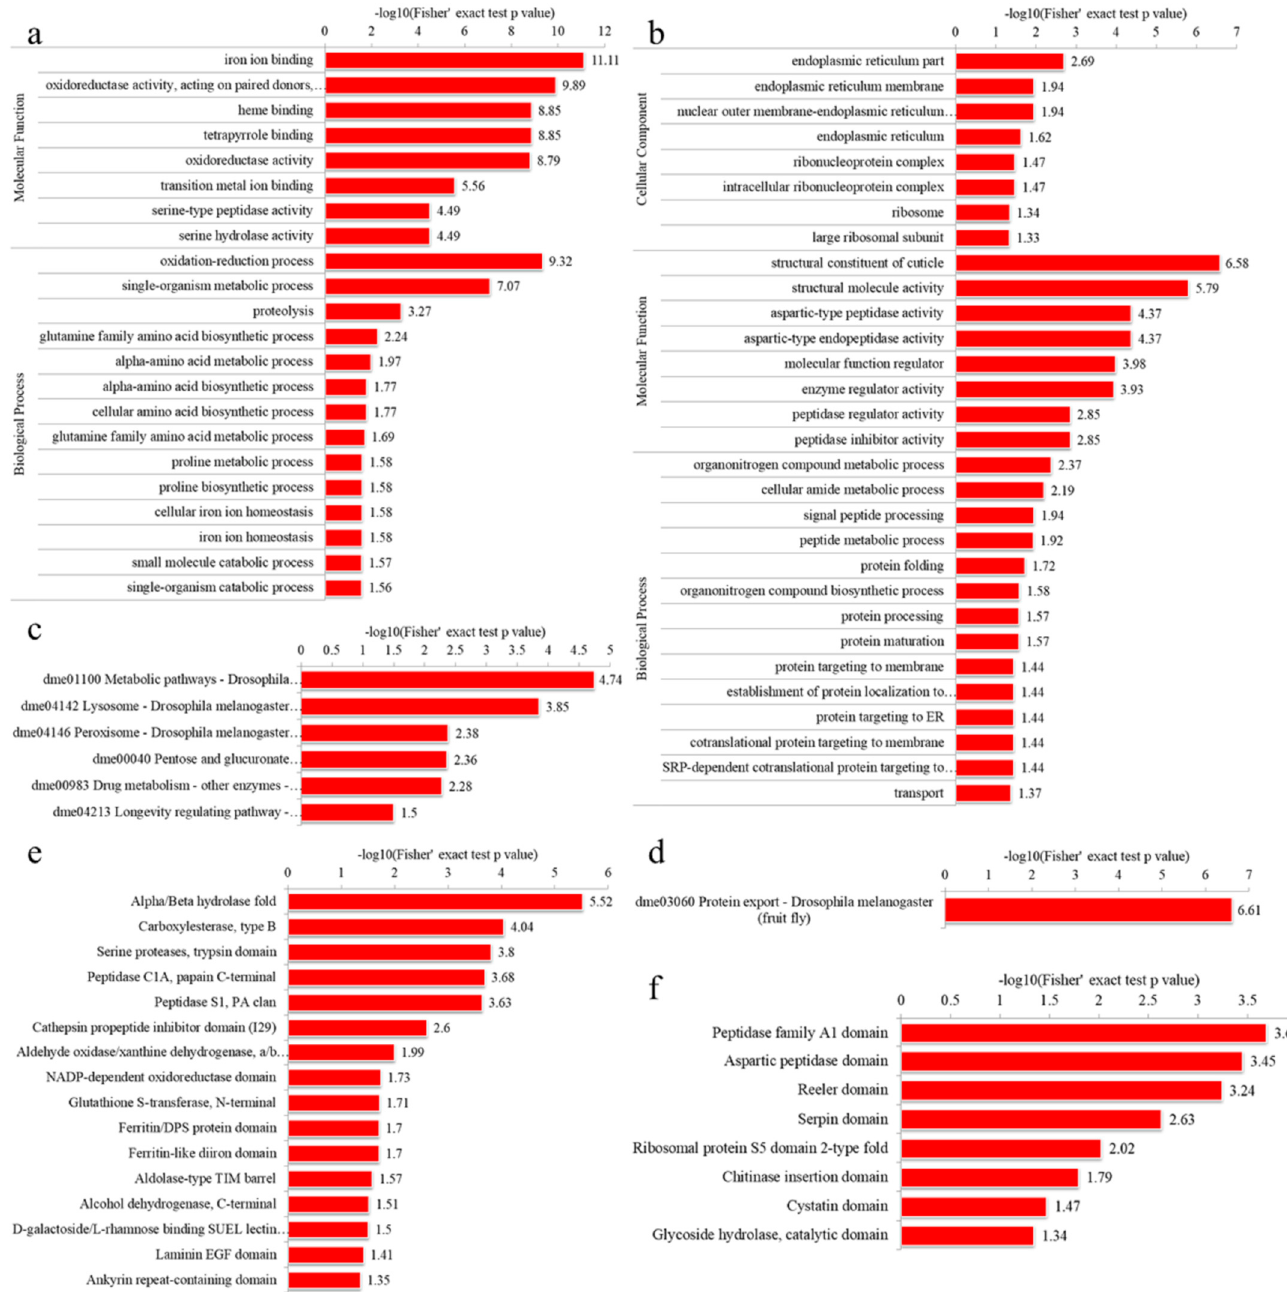
Figure 8. Enrichment analysis of the DEPs in IADN/COSMN group: ( a ) A GO-based enrichment analysis of the up-regulated DEPs; ( b ) A GO-based enrichment analysis of the down-regulated DEPs; ( c ) KEGG pathway enrichment analysis of the up-regulated DEPs; ( d ) KEGG pathway enrichment analysis of the down-regulated DEP; ( e ) protein domain enrichment analysis of the up-regulated DEPs; ( f ) protein domain enrichment analysis of the down-regulated DEPs.